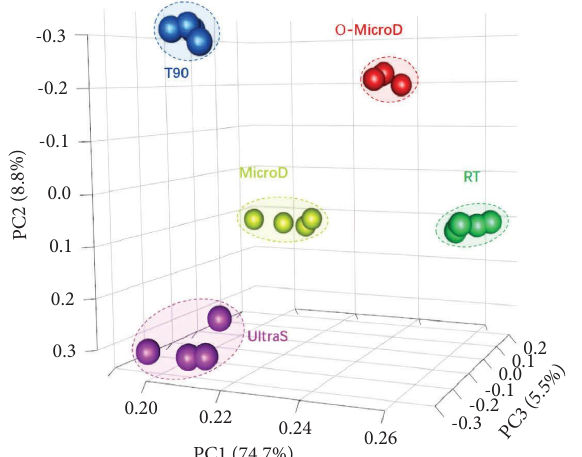
Figure 2: Principal component analysis (PCA) of the human hair elements, digested using fve diferent methods. Each color represents a digestion method. An ellipse with dotted lines indicates the 95% confdence interval calculated using Hotelling’s T2